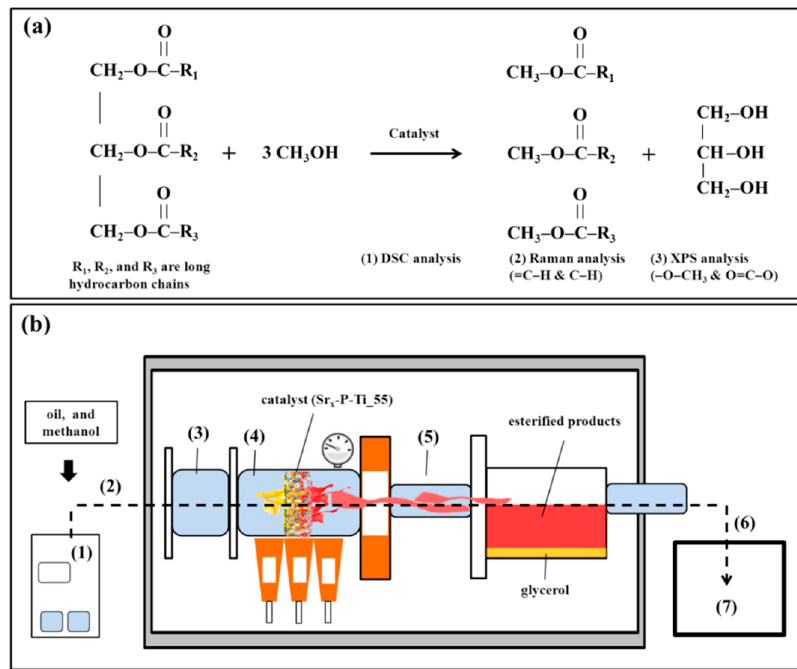
Figure 6. ( a ) The reactants and the products for the transesterification reaction of olive oil by SrO catalyst, which are respectively characterized by: (1) DSC, (2) Raman Spectroscopy, and (3) XPS. ( b ) A layout for a high-throughput transesterification process using Sr x -P-Ti_55 as a dynamic and